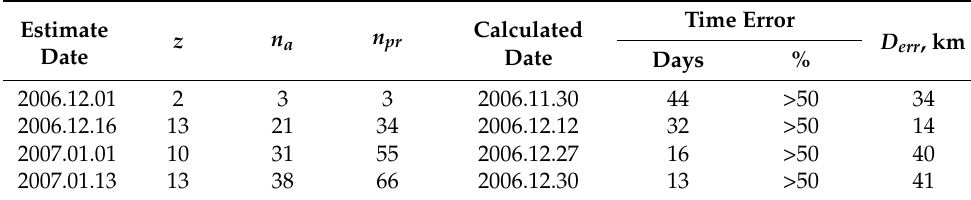
Figure A6. Retro predictability of the earthquake on 13 January 2007 in the zone with the highest (at the estimate date; see Figure A5, column ‘a’) number of successful predictive extrapolations (see Figure A4 for explanations). Table A6. Retro estimation of the place and time of the earthquake on 13 January 2007 by the cluster of its precedent activity.